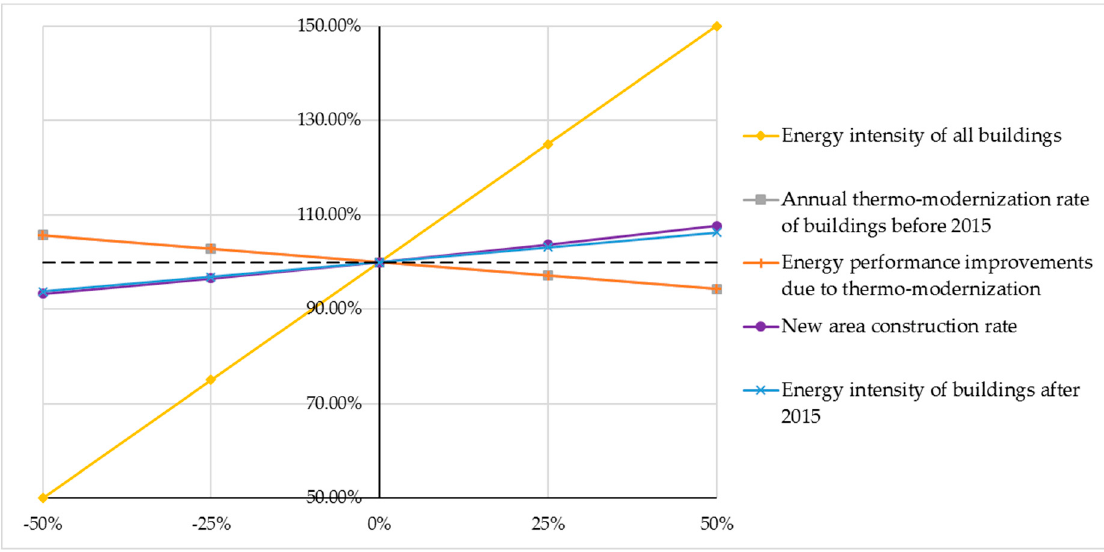
Figure 9. Sensitivity analysis related to the heat demand in 2030.